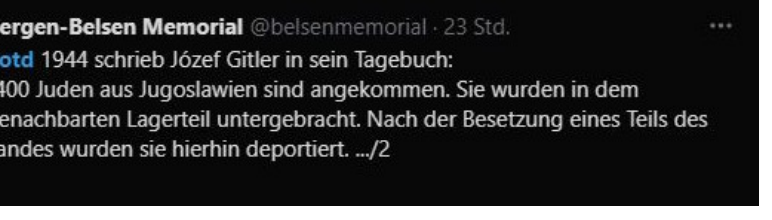
Figure 13. An On-this-day tweet on 23 June. Here, Gitler describes the arrival of a new group of 400 Jewish prisoners from